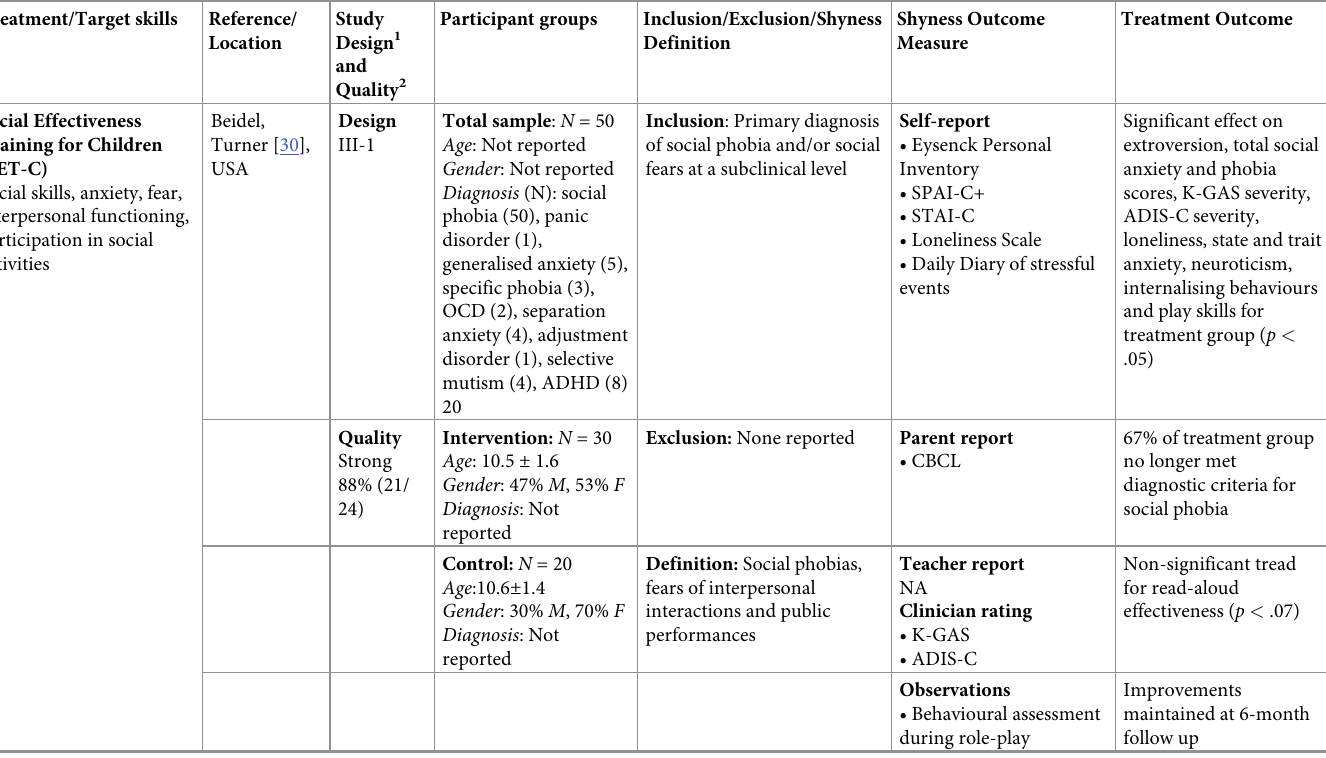
Table 2. Characteristics of included